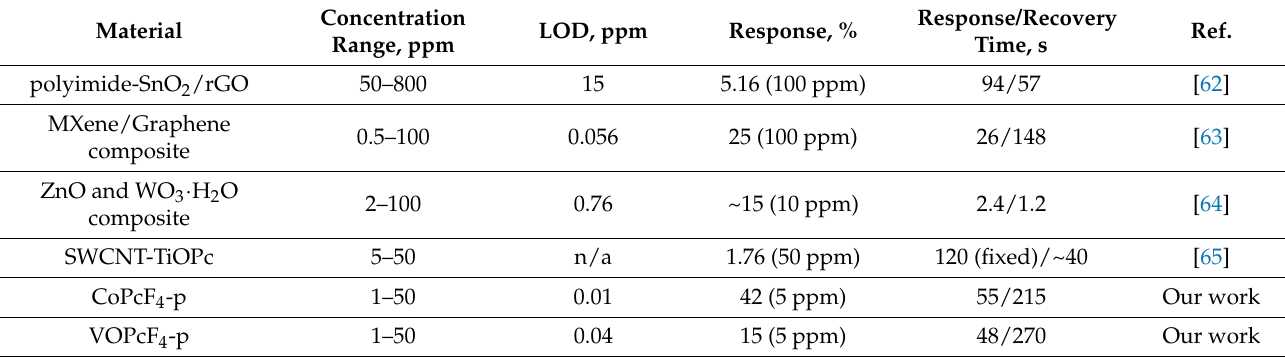
Table 5. Sensor characteristics of various chemiresistive sensors to Figure 13. ( a ) Sensor response of a CoPcF 4 -p film to ammonia (3 ppm) after 7, 14, 28, and 120 days. ( b ) Diagram of sensitivity of a CoPcF 4 -p film to various gaseous analytes and volatile organic va- pors.